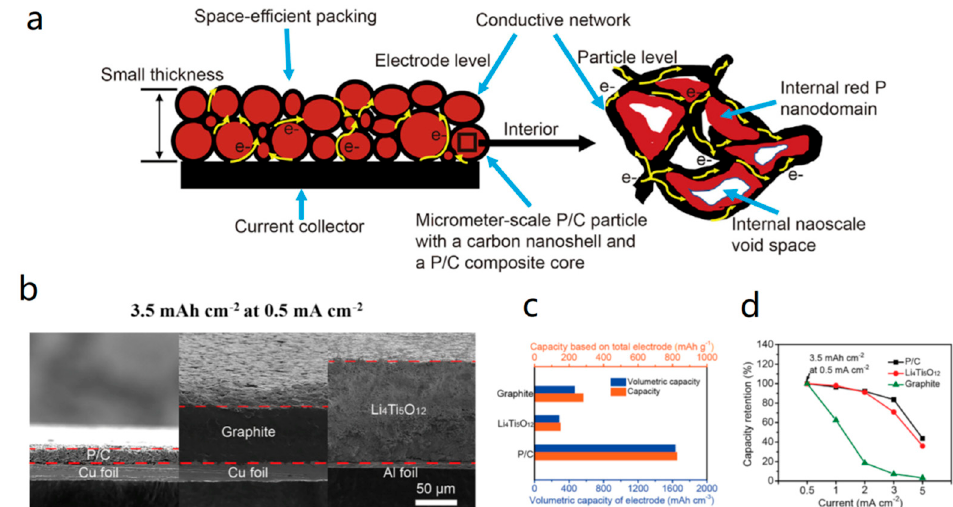
Figure 12. Schematic of material choice and structure for fast-charging LIBs [103] ( a ). Comparison of the thicknesses and weights [102] ( b ); and capacities and volumetric capacities based on the total electrode (active material, binder, and carbon) for P / C, graphite, and Li 4 Ti 5 O 12 electrodes with the same areal capacity 3.5 mAh cm 2 at 0.5 mA cm 2 ) [102] ( c ). Comparison of capacity retentions for P / C, commercial Li 4 Ti 5 O 12 , and graphite electrodes with the same areal capacity of 3.5 mAh cm 2 at 0.5 mA cm 2 . All the electrodes comprise 90 wt % materials, 5 wt % binder, and 5 wt % carbon black [102] ( d ). Reproduced by permission of